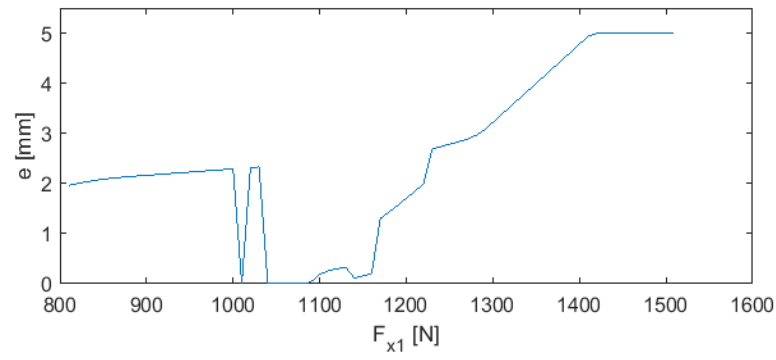
Figure 25. Neural-genetic controller for a = 100 mm and a = 200 mm.